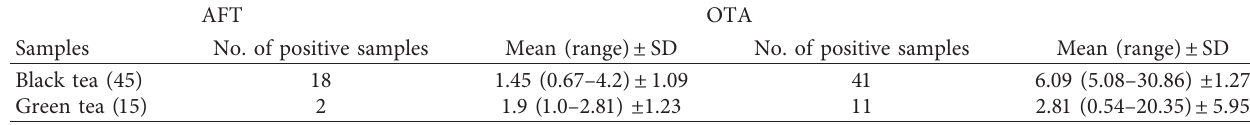
Table 2: Concentration of mycotoxin in tea samples.